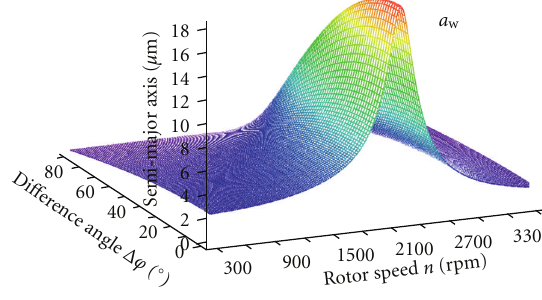
Figure 10: Semi-major axis a w of the absolute orbit of the shaft centre point W , depending on the rotor speed n and on the di ff erence angle Δ ϕ